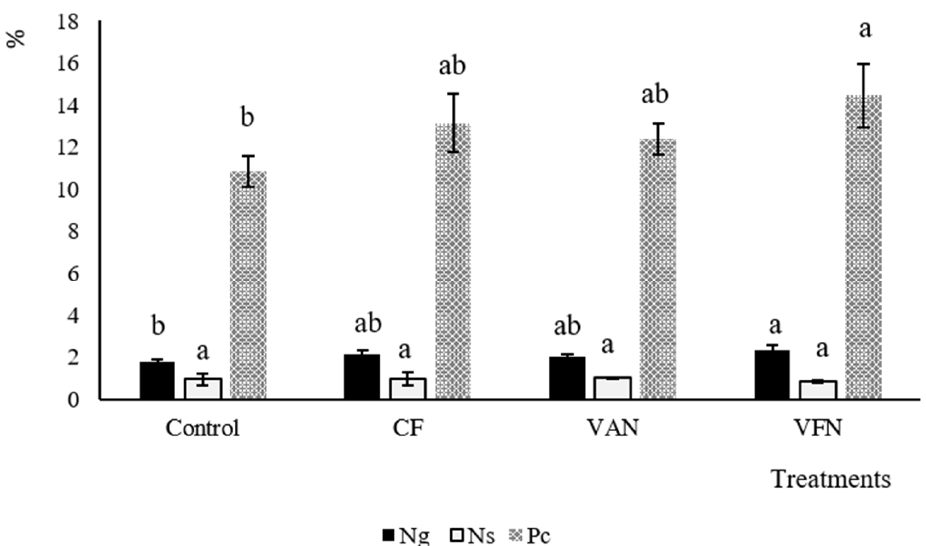
Figure 6. Effect of different N treatments on grain (Ng) and straw (Ns) N uptake and protein concentration (Pc) (%) of barley cultivated during the season 2018/2019. Bars with the same letter are not significantly different ( p > 0.05). Control (0 kg N ha − 1 ); CF (conventional fertilization—150 kg N ha − 1 ); VAN (variable N application rate with ammonium nitrate—35 kg N ha − 1 ); VFN (variable N application rate with a foliar liquid N fertilizer—35 kg N ha − 1 ). Different letters indicate significant difference, according to Dunn’s post-hoc test ( p < 0.05), between treatments.